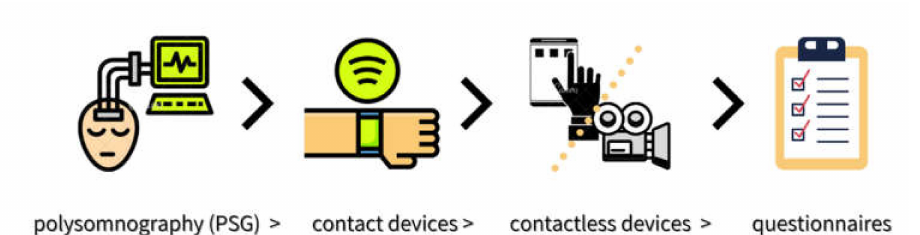
Figure 2. A relative hierarchy in order of sleep assessment